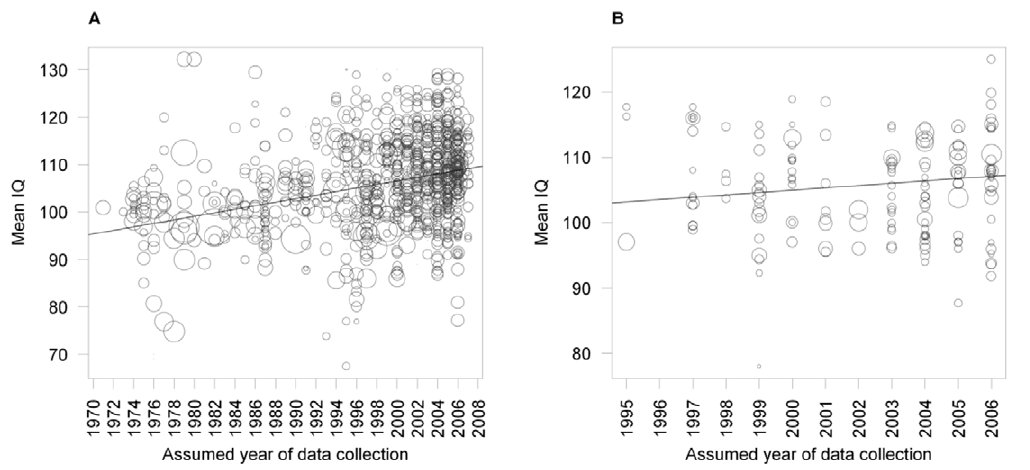
Figure 2. Intelligence test gains on two measures of crystallized intelligence. Note. Symbol size is varied according to study weight. (A) Mean IQ of 960 independent samples for the MWT in assumed year of study performance 1971–2007. (B) Mean IQ of 164 samples for the WST in assumed year of study performance 1995–2006.